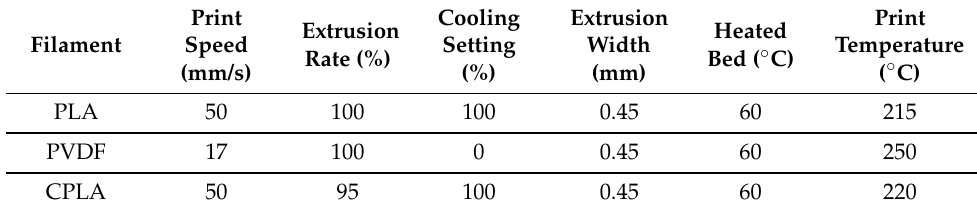
Table A1. The 3D printing parameters used for fabrication of 3D-printed PE